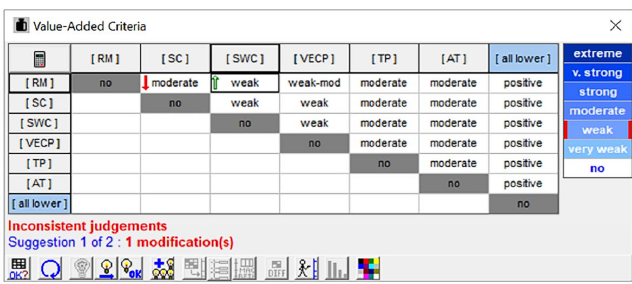
Figure 5. Consistency suggestion in M-MACBETH